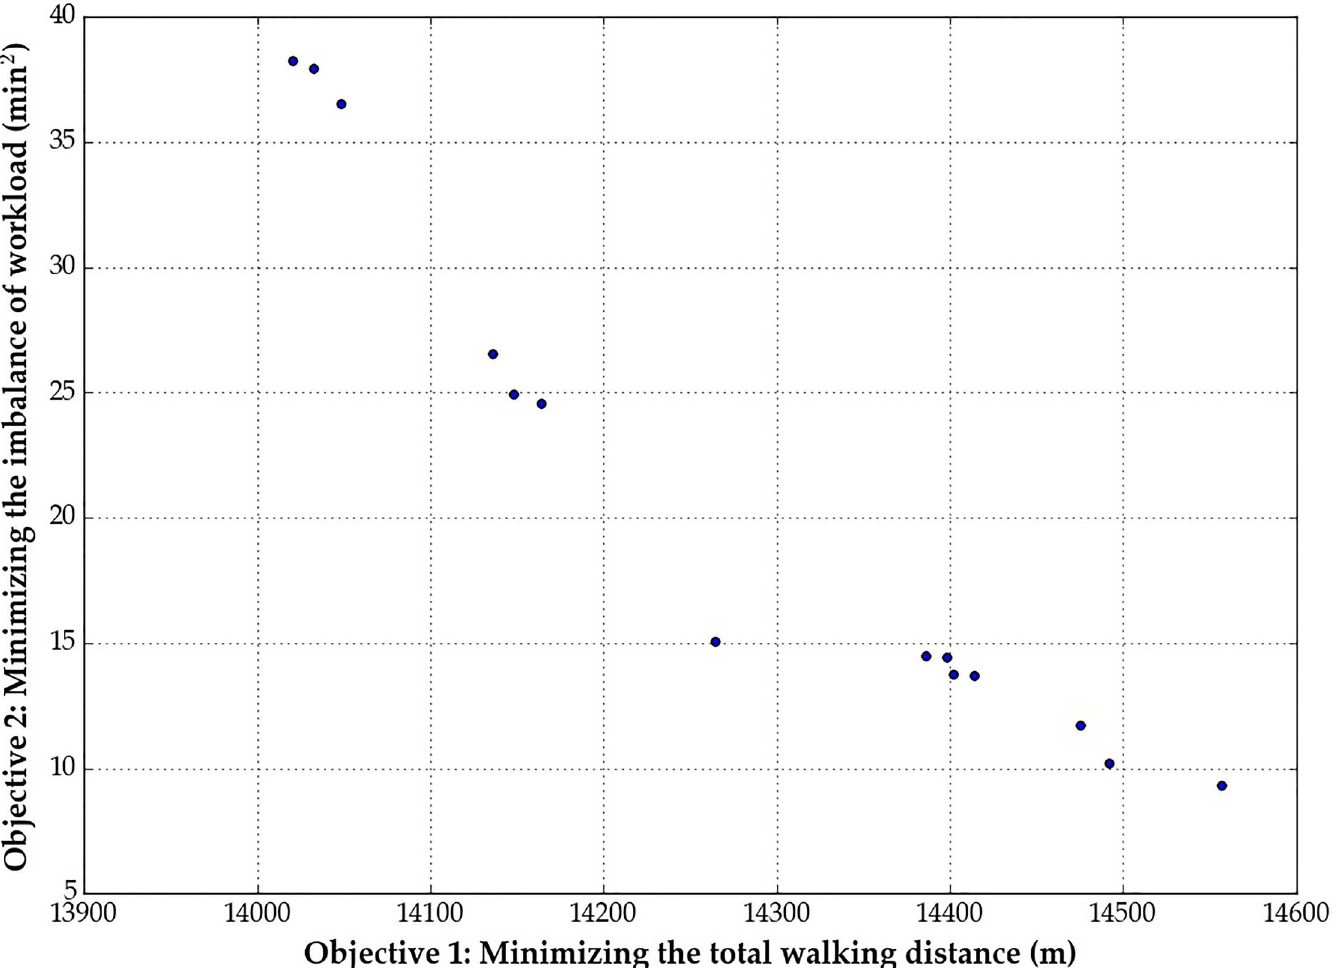
Fig 7. Pareto points with the Pareto filter.